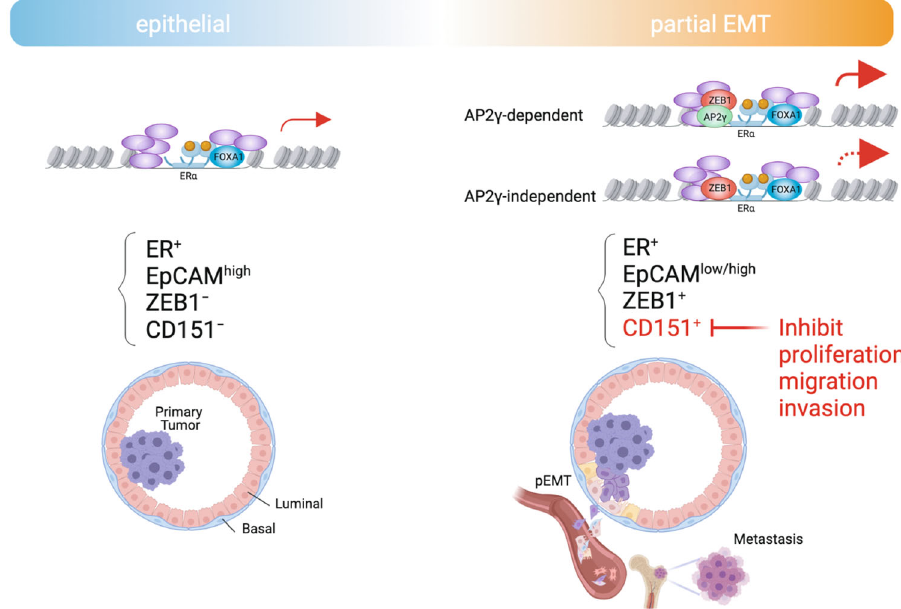
Fig. 8 Scheme indicating the role of the ZEB1-ER α complex during early/hybrid EMT stages of breast cancer. Non-invasive primary epithelial breast tumors (EpCAM high ) that express high levels of ER α and are negative for ZEB1 expression are formed by the abnormal proliferation of luminal mammary epithelial cells. FOXA1 acts as the main pioneer factor for the recruitment of ER α for transcription of genes involved in cell proliferation. In early/hybrid states of EMT, AP2 γ becomes a determining pioneer factor promoting the formation of a ZEB1-ER α complex at ER α binding sites, which enhances ER α target gene expression. Without AP2 γ recruitment, FOXA1 and/or other factors may partially sustain ER α recruitment to ERBSs and ER α -stimulated transcription. This complex reprograms the ER α cistrome and transcriptome towards the activation of genes involved in partial EMT and metastatic dissemination. Expression of speci fi c factors such as CD151 marks the partial EMT state. CD151 could potentially be targeted to prevent cancer cell proliferation, migration, and invasion. The illustration was created with